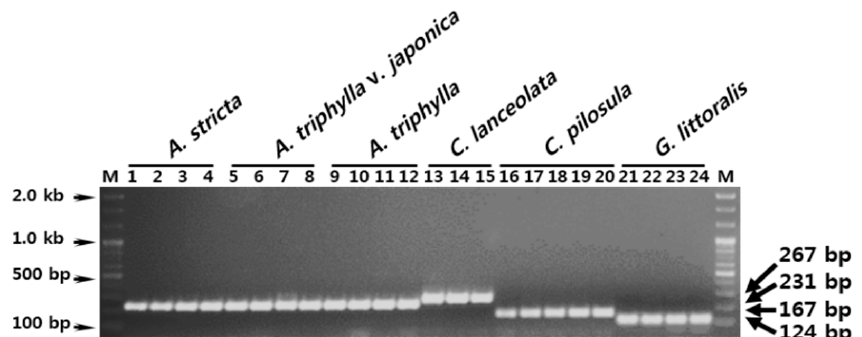
Figure 3. Establishment of a multiplex-PCR assay using species-specific SCAR markers. The numbers 1–24 correspond to those listed in Table 1. The precise lengths of DNA fragments are indicated to the right side of the gel images. M represents the 100 bp DNA ladder.